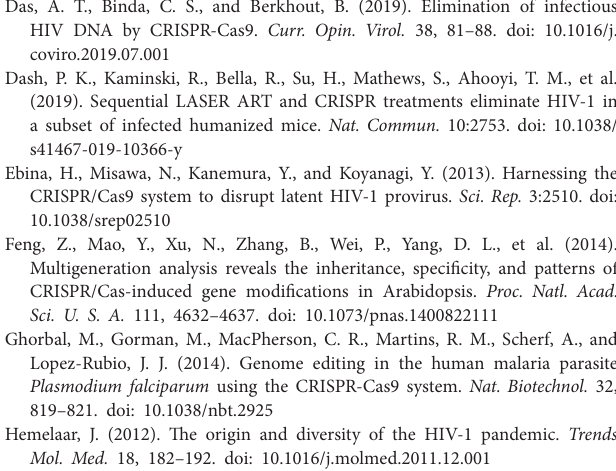
Supplementary Figure S1 | Analysis of the sequences of HIV-1 mutation sites in dual-sgRNAs/Cas9-treated J-Lat 10.6 cells. Feature of the mutations in the three most efficient dual-sgRNA combinations: (A) sg-Gag1-J + sg-Gag4-J (B) sg-Gag1-J + sg-Pol1-J (C) sg-Gag2-J + sg-Pol1-J. All sequences were aligned with the reference strain HXB2. The 20 nt guide sequence and the PAM sequence are underlined. The sequences of nucleotide substitutions, insertions, and deletions are indicated using red letters. Ref, reference sequence; − x/+x, x nt deleted/inserted; NS, nucleotide substitution; WT, wild-type sequence. Supplementary Figure S2 | Sequence analysis of HIV-1 mutation sites in J-Lat 10.6 cells treated with dual-sgRNAs/Cas9. Features of the mutations in the three most efficient dual-sgRNA combinations: (A) sg-Gag2-J + sg-Gag5-J (B) sg- Pol1-J + sg-Pol3-J (C) sg-Tat1-J + sg-Env2-J. All sequences were aligned with the reference strain HXB2. The 20 nt guide sequence and the PAM sequence are underlined. The sequences of nucleotide substitutions, insertions, and deletions are indicated using red letters. Ref, reference sequence; − x/+x, x nt deleted/ inserted; NS, nucleotide substitution; WT, wild-type sequence. Supplementary Figure S3 | Deletion of the entire viral DNA between two sgRNA-targeted sites in the combination sg-Gag1-J + sg-Gag2-J (A) 169 bp deletion (B) 177 bp deletion with two single-base